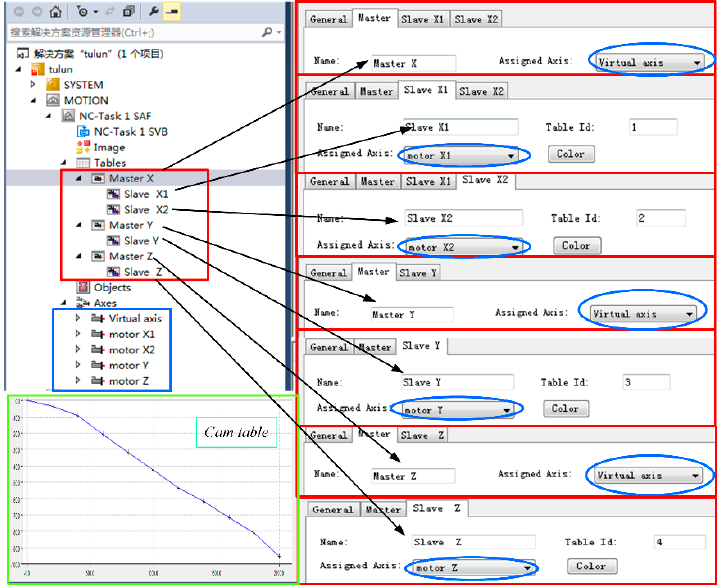
Figure 14. Creating virtual master axis, electronic cam slave axis and cam table.